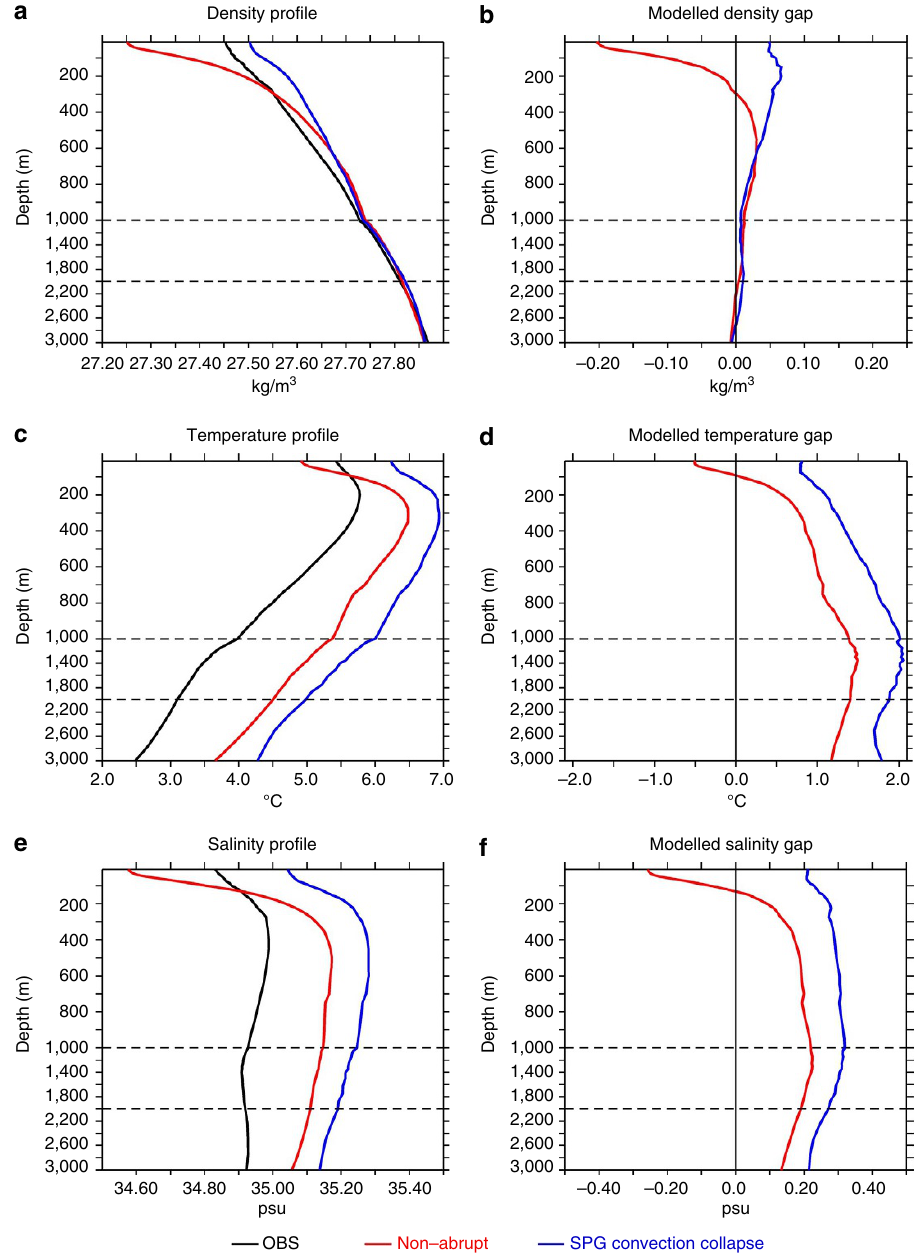
Figure 6 | Different SPG stratifications in the model sub-ensembles and their comparison with the observational data. Present-day vertical profiles of ( a ) winter density (kgm (cid:3) 3 ), ( c ) temperature ( o C) and ( e ) salinity (psu) in the SPG region for observational data (black lines), for ensemble-mean of non-abrupt models (red lines) and for ensemble-mean of the SPG convection collapse models (blue lines). Right panels show the difference between the modelled present-day winter conditions in the SPG and the observation-based data ( b ) for density, ( d ) for temperature and ( f ) salinity. Horizontal dashed lines are drawn at every 1,000 metre. A zoom has been made for the first 1,000